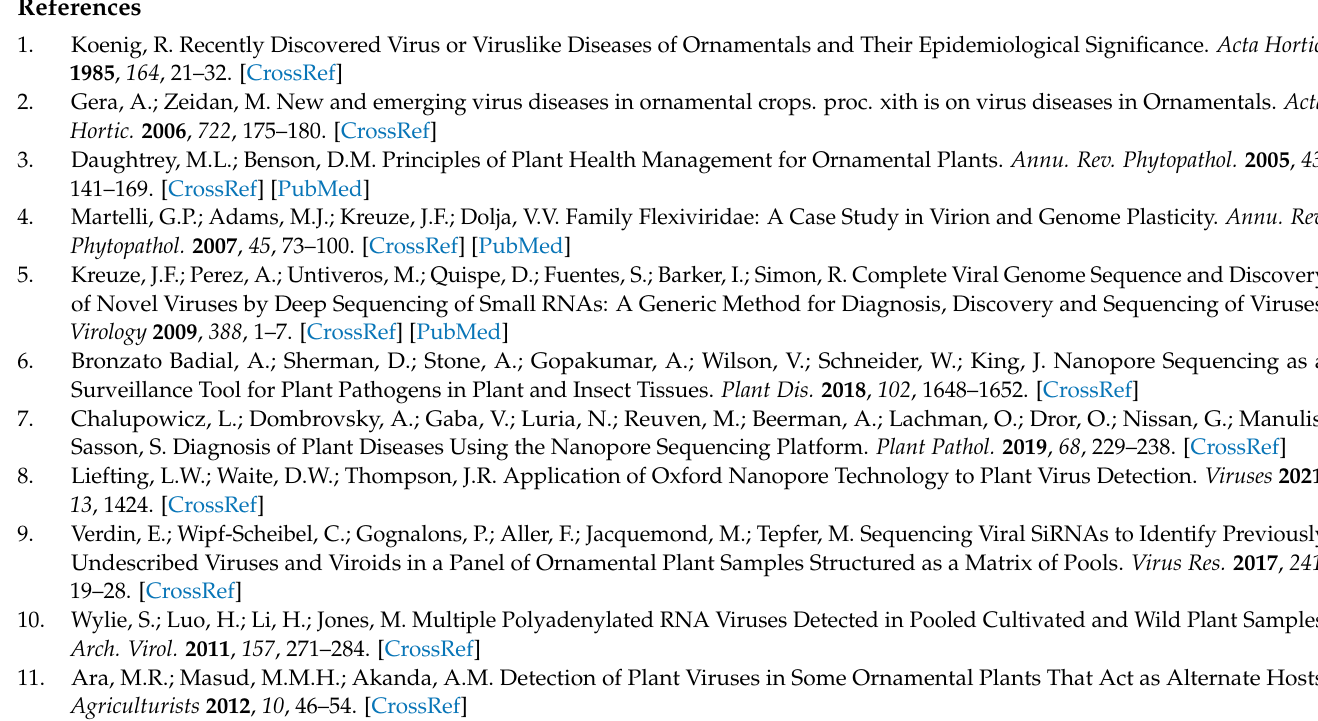
Figure S1: Graphic representation of InterPro and CCD protein domain searches and annotations of jasmine virus C—Bari genome; Supplementary Figure S2: Alignment of the nucleic acid-binding proteins of JaVC available in GenBank; Supplementary Figure S3: Alignment of coat proteins of selected carlavirus